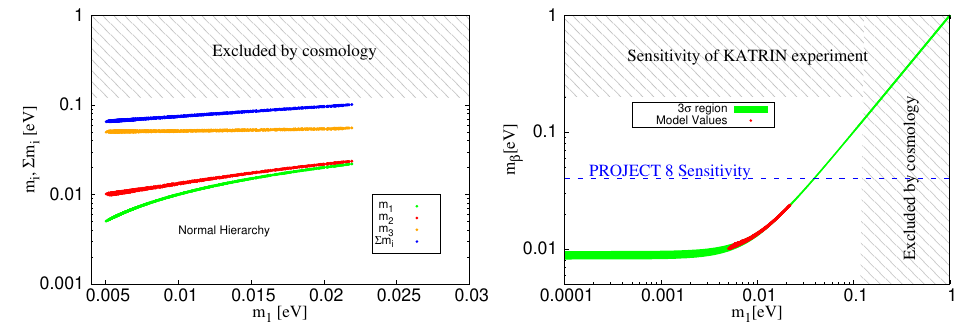
Figure 2 . Left: prediction for the absolute neutrino masses and their sum P m i as a function of m 1 . Right: m as a function of m where the gray dashed vertical region is disfavored by Planck+BAO β 1 while the gray dashed horizontal region is the limit on m from KATRIN β